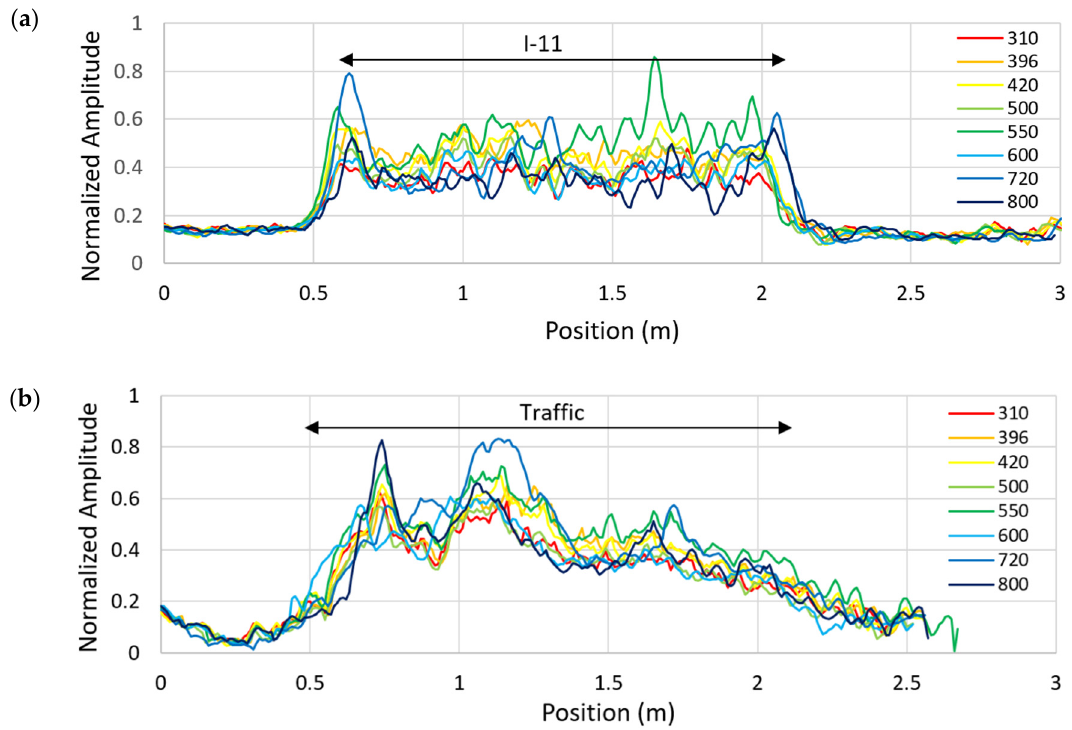
Figure 16. 1.5 GHz Norm. RW amplitudes on sand (I-11) in the ( a ) long. and ( b ) transv. direction vs. K loadings.